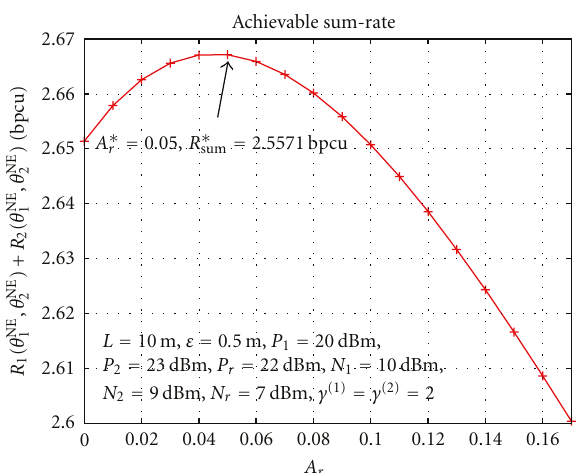
Figure 5: ZDSAF relaying protocol with fixed amplification gain. Achievable network sum-rate at the NE as a function of A r ∈ [0, a r ] for L = 10m, ε = 0 . 5m, P 1 = 20dBm, P 2 = 23dBm, P r = 22 dBm, N 1 = 10dBm, N 2 = 9dBm, N r = 7dBm, γ (1) = γ (2) = 2. The = 0 . 05 ≤ a = 0 . 17 meaning optimal amplification gain A ∗ r (1,1) r that saturating the relay power constraint is